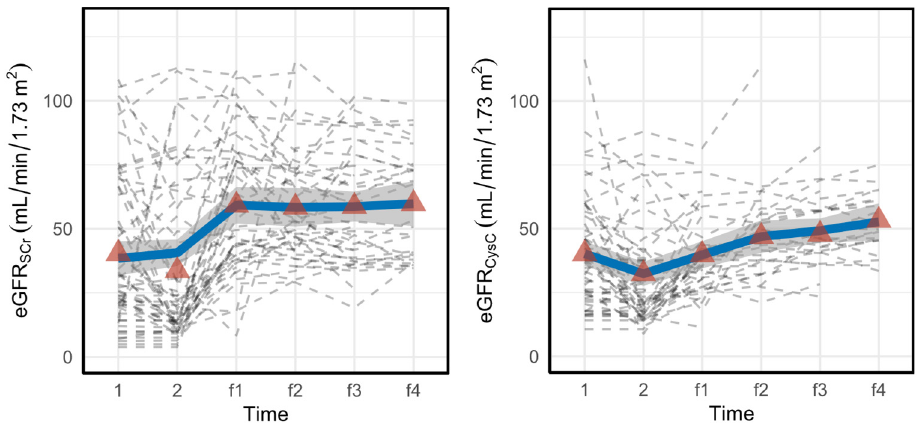
Figure 4. Within-subject evolution of eGFR for alive patients from the first day in ICU until the last follow-up. The dashed gray lines represent each subject, the red triangles show the average eGFR values at that specific time point, and the blue lines are smooth curves obtained via locally estimated scatterplot smoothing (LOESS). The gray band is a 95% confidence band for the regression line.